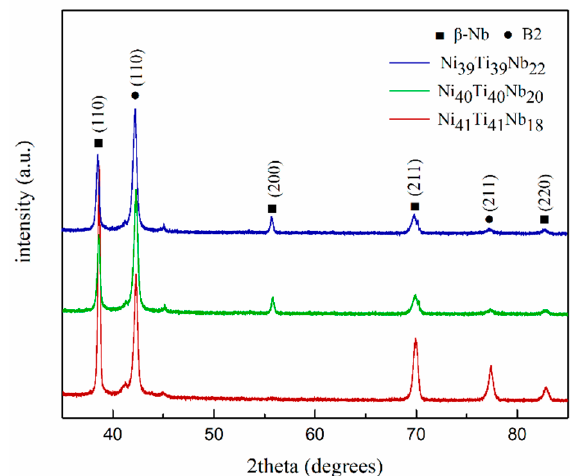
Figure 2. XRD patterns and their identification of Ni50 − x /2 Ti50 − x /2 -Nb x ( x = 18, 20, 22) alloys after solution at 850 °C for 1.5 h.